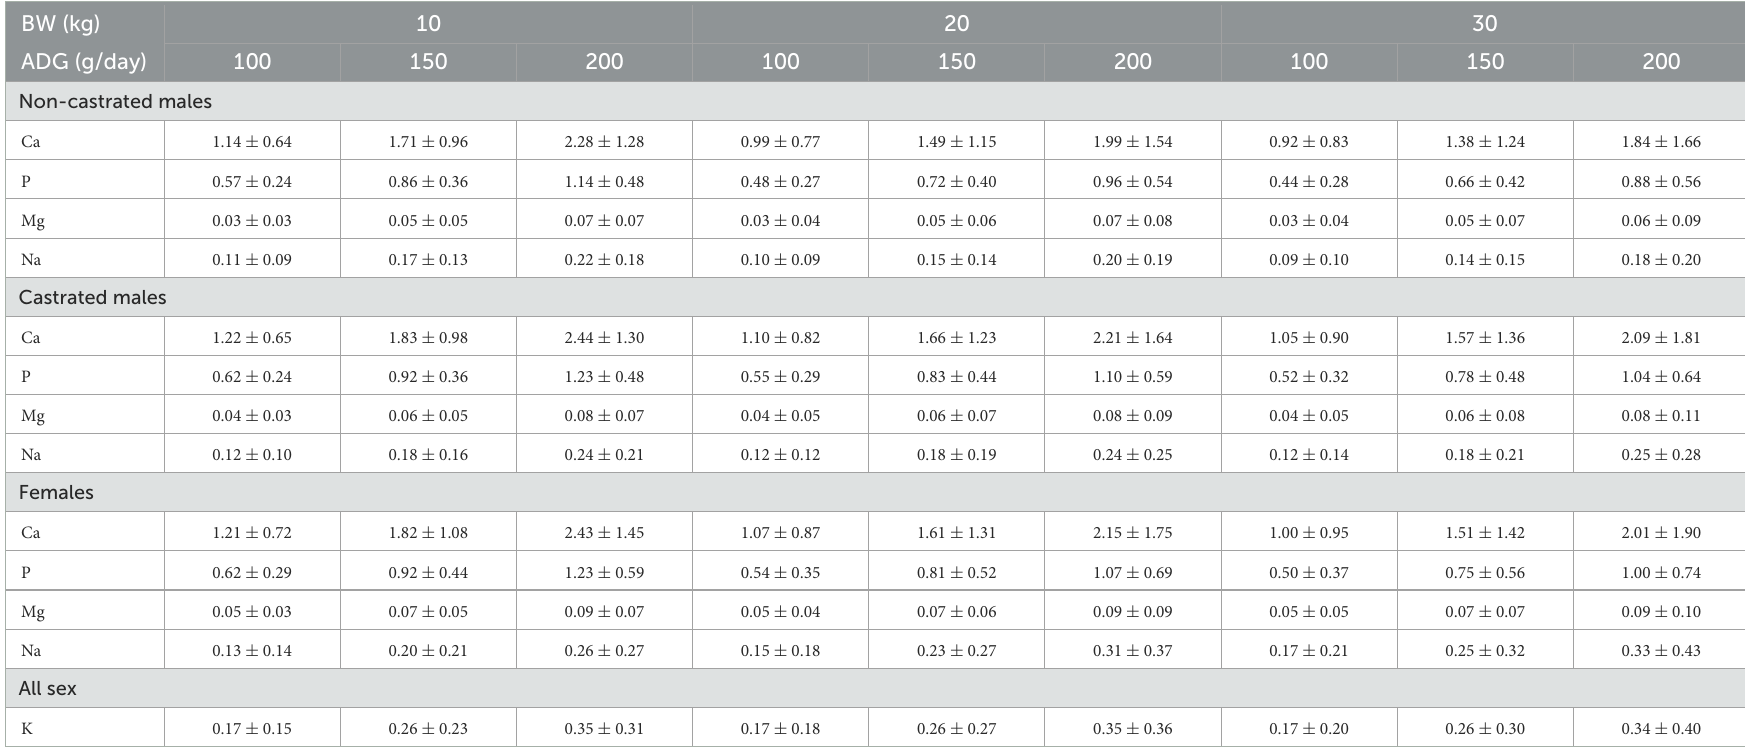
TABLE 6 Net mineral requirements for gain of hair sheep with respective confidence